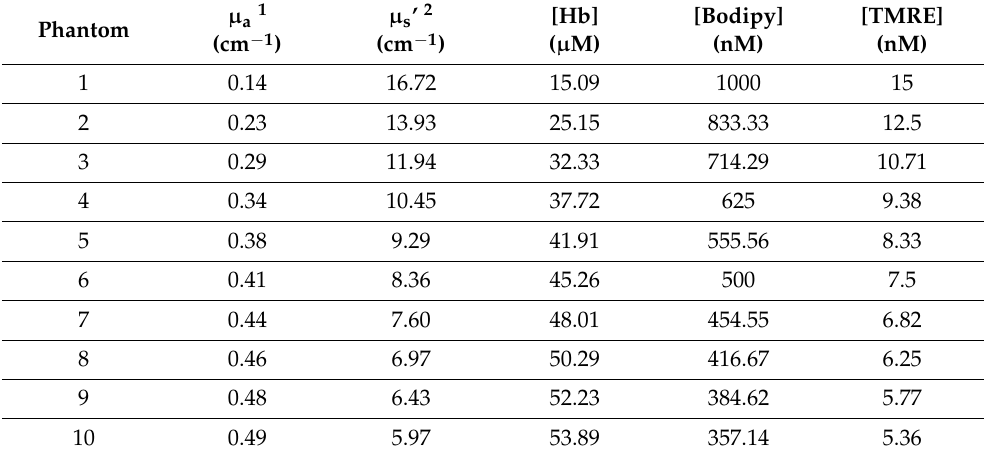
Table 1. A series of ten tissue-mimicking liquid phantoms containing Bodipy FL C16, TMRE, hemoglobin, and microspheres at varying concentrations were prepared. Table 1 shows the ab- sorption coefficient ( µ a , cm − 1 ), reduced scattering coefficient ( µ s (cid:48) , cm − 1 ), hemoglobin concentration ( µ M), and fluorophore concentrations (nM) for each